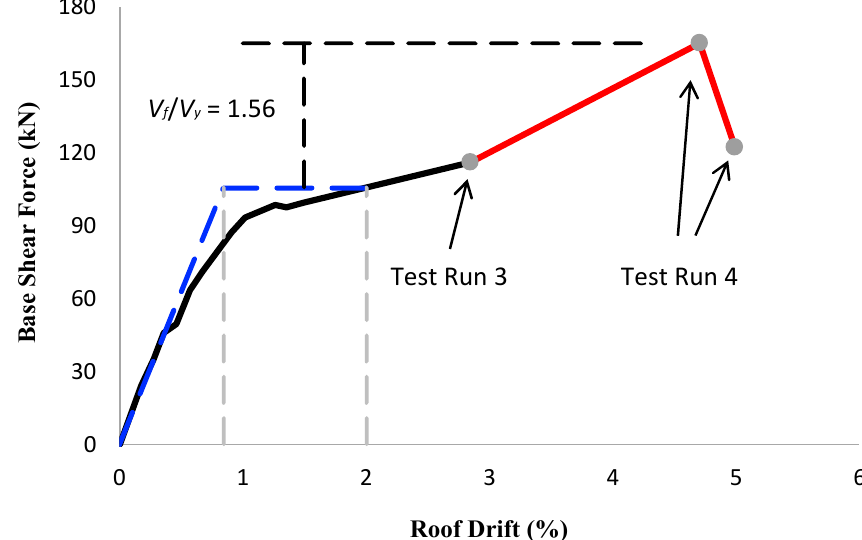
Figure 14. Complete capacity curve for prototype of tested frame till beam–column joints were extensively damaged.